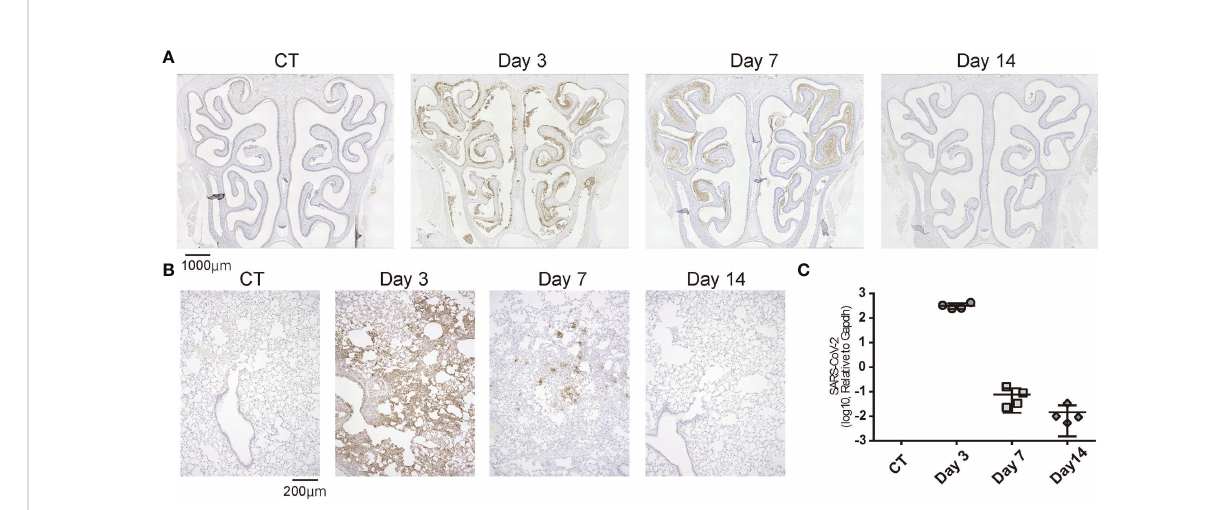
FIGURE 2 Temporal SARS-CoV-2 infection fi ndings in the nose and lungs. (A) Representative images of immunohistological staining of severe acute respiratory syndrome coronavirus 2 (SARS-CoV-2) in control (CT) hamsters and SARS-CoV-2 hamsters on days 3, 7, and 14. SARS-CoV-2 is shown in brown. (B) Immunohistochemistry staining of SARS-CoV-2 in the lung. (C) : SARS-CoV-2 gene detection with RT- quantitative polymerase chain reaction in the CT hamster and SARS-CoV-2 hamsters on days 3, 7, and 14. SARS-CoV-2, severe acute respiratory syndrome coronavirus 2.